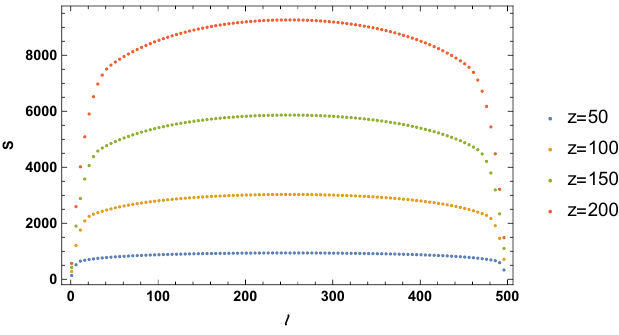
Figure 5 . EE for large regions ‘